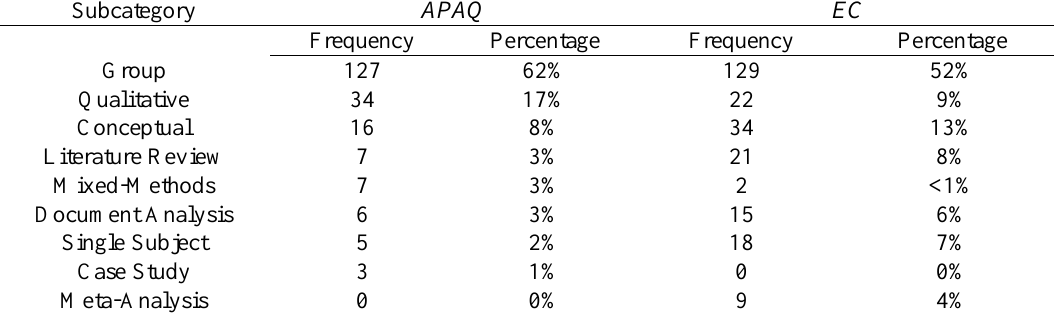
Table 1. Publication/ Research Methods across